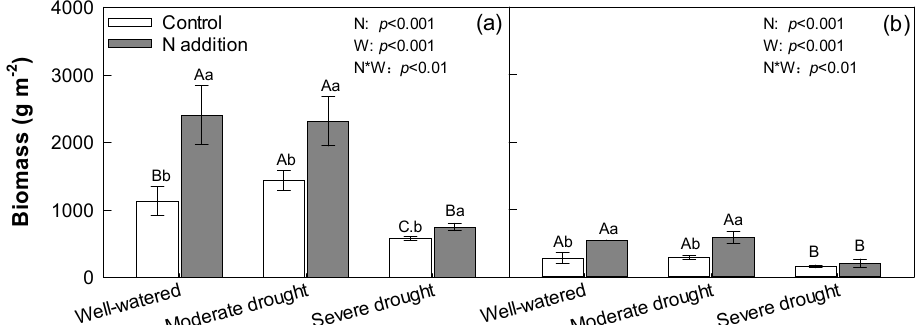
Figure 3. Aboveground ( a ) and belowground ( b ) biomass under different treatments. The error bar represented arithmetic means ± standard errors for three replicates. Different superscript indicates significant differences between N addition treatments under the same drought treatment (lowercase letters) and different drought treatments under the same N addition treatment (uppercase letters). * represents interactions.